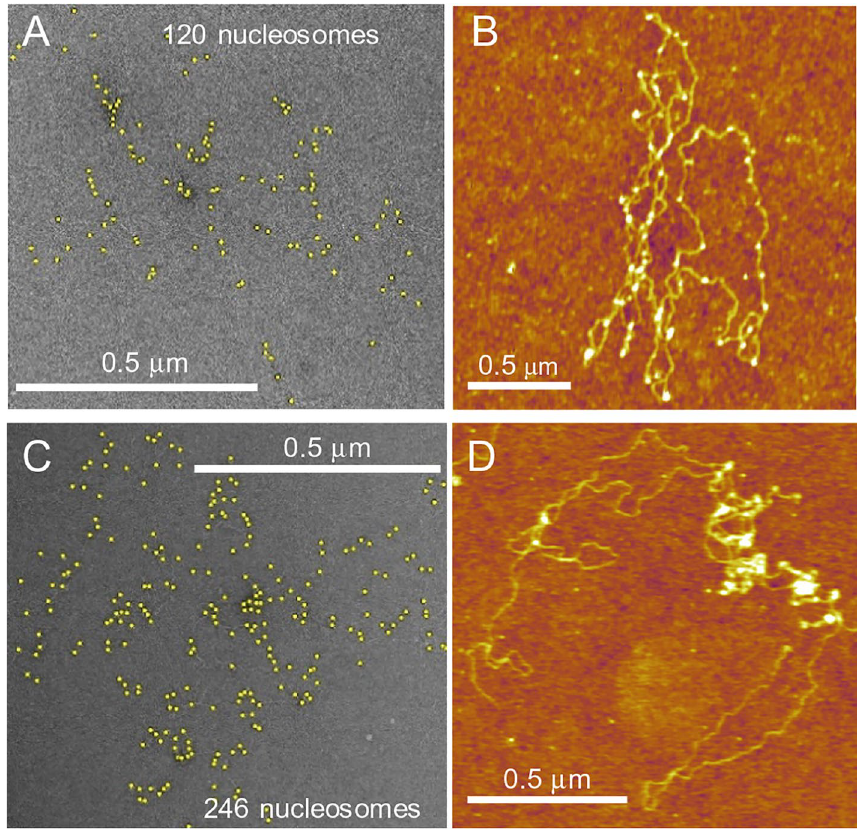
Figure 3. EM and AFM images illustrate the formation of heterogeneous nucleosome clusters in the λ-arrays. ( A – D ) Images of the λ-DNA arrays obtained for the HO:DNA 0.5 ( A , B ) and 1.0 ( C , D ) by the negative staining EM ( A , C ) and the AFM ( B , D )